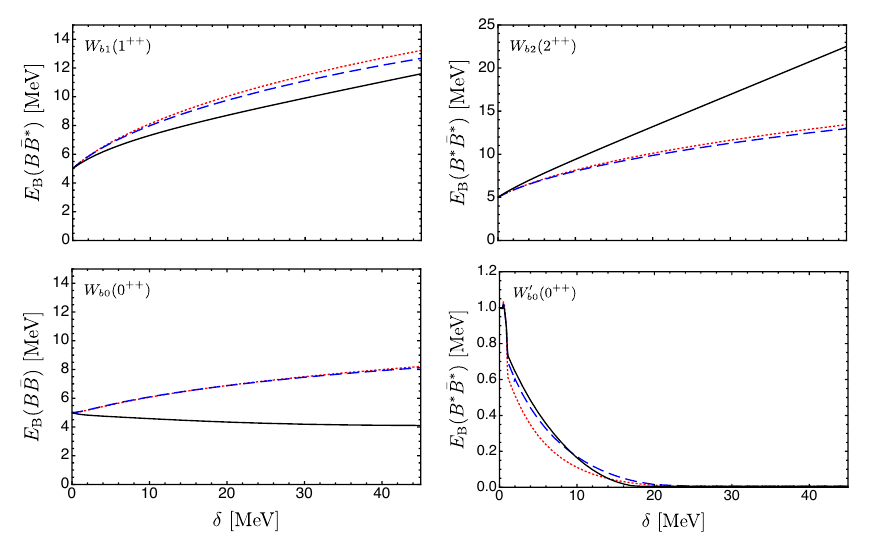
Figure 1. Evolution of the binding energies of the Z b ’s spin partners as functions of the mass splitting δ between the B ∗ and B mesons. The red dotted curves correspond to the pionless (purely contact) theory; the blue dashed curves are obtained for the central ( S -wave) part of the OPE included; the black solid curves represent the results for the problem with the contact plus full OPE interactions, including tensor forces. The physical mass splitting corresponds to the right edge of the plots. Please note the di ff erent scales for each of the